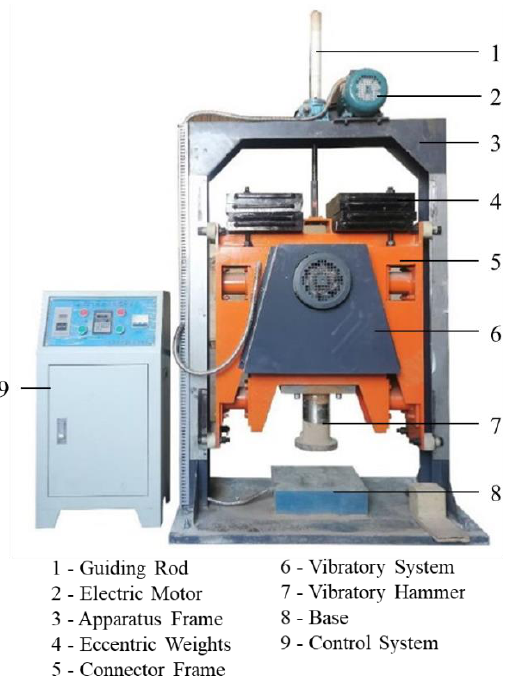
Figure 3. The new plate vibratory compaction apparatus developed at Central South University.